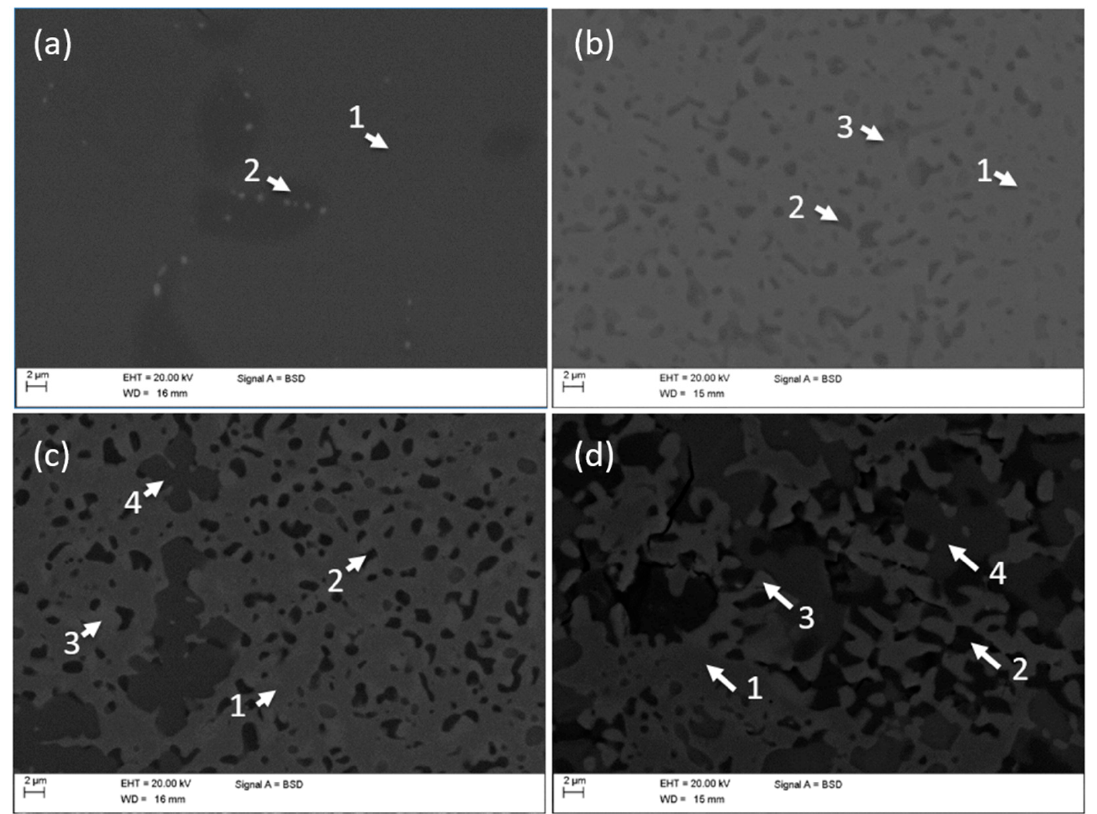
Figure 1. BSE-SEM images of Cu 50 Zr 50 after MT stabilization ( a ) and Cu (50 − x) Zr 50 Al x with x = 5, 10, 15 at. % ( b – d ) before thermal cycling, respectively. Table 1. EDS measurements of the CuZr based sample, performed on the sites depicted in Figure 5.